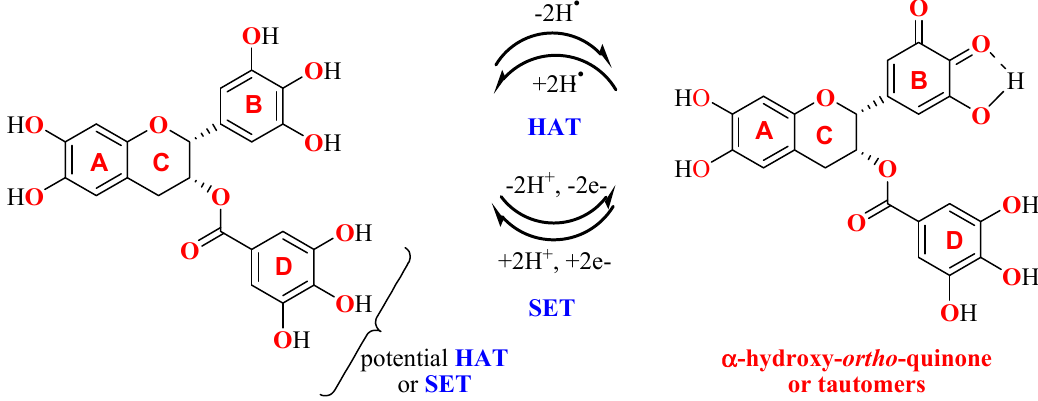
Scheme 1. α -hydroxy- ortho -quinone formation from EGCG by Hydrogen Atom Transfer (HAT) or Single Electron Transfer Mechanisms (SET).